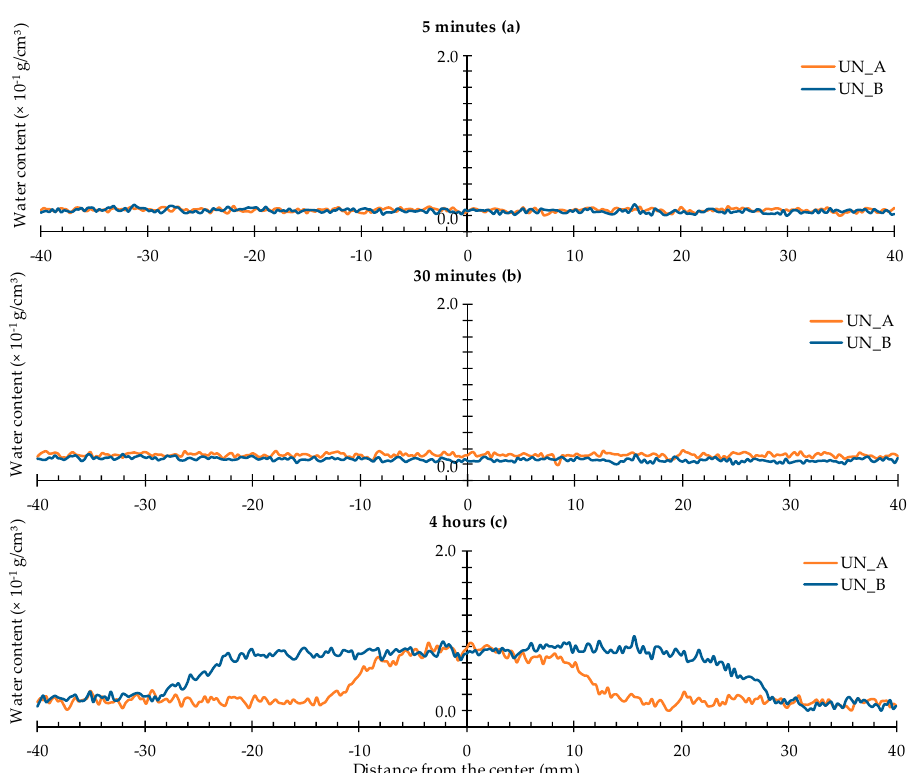
Figure 9. Water profiles of the two uncracked standard mortar prisms: ( a ) after 5 min; ( b ) after 30 min; and ( c ) after 4 h.